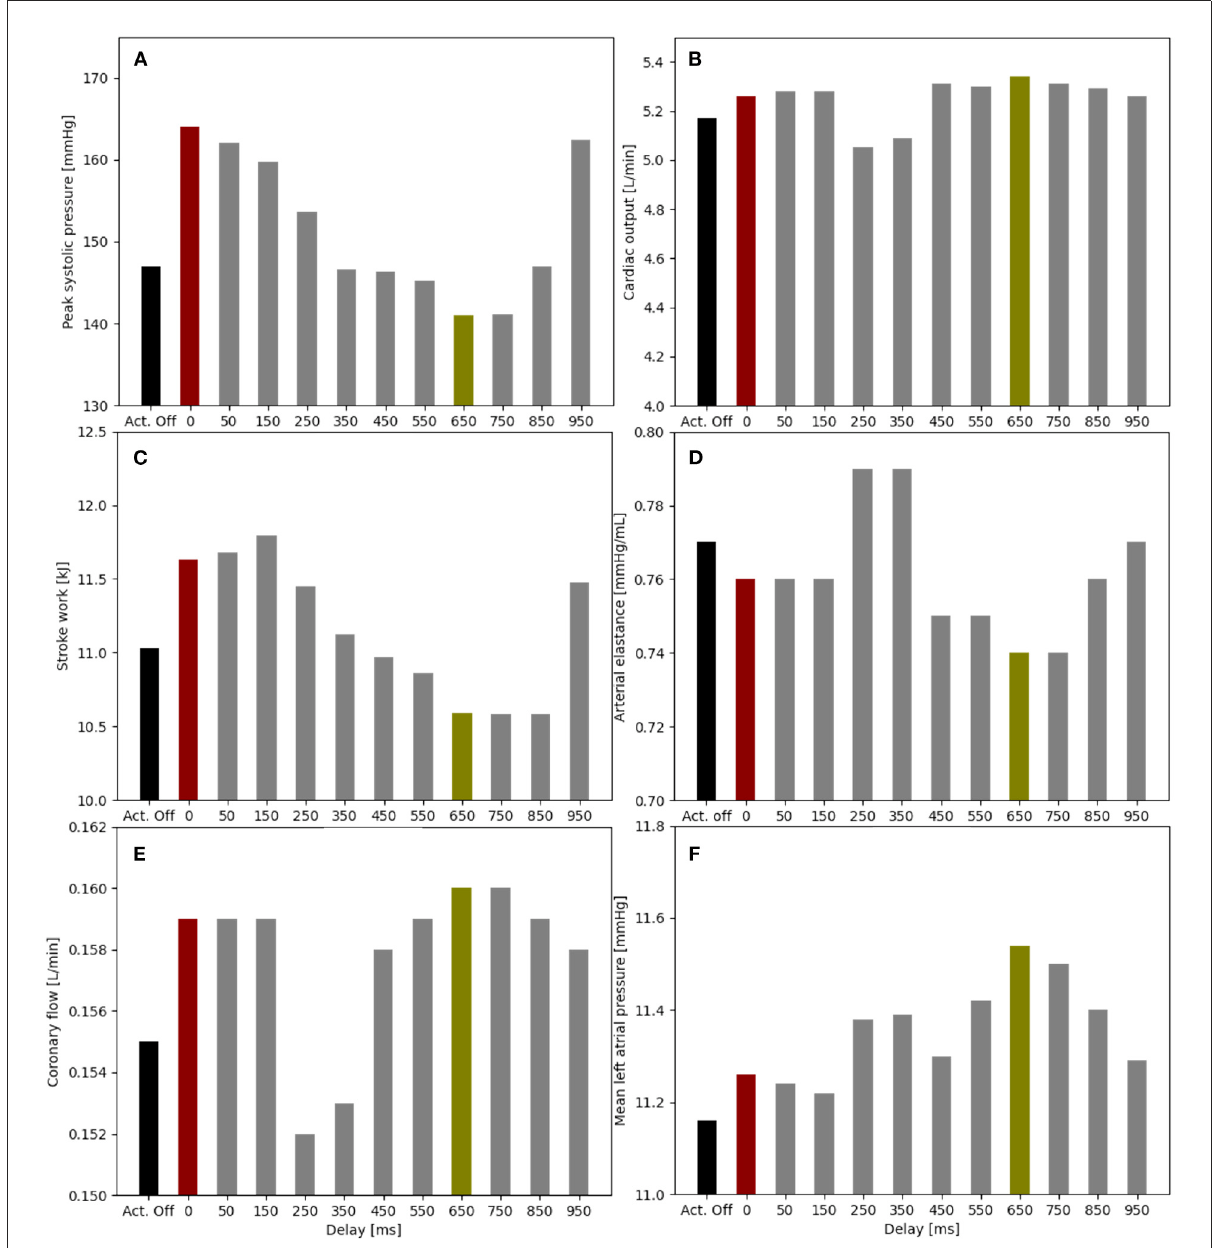
FIGURE5 Impact of the soft robot delay on peak systolic pressure (A) , cardiac output (B) , stroke work (C) , arterial elastance (D) , coronary flow (E) , and mean left atrial pressure (F) ( p act = 12 psi). Optimal case for delay at 650 ms (green), baseline for actuator off (Act. Off) (black) and worst case for delay at 0 ms